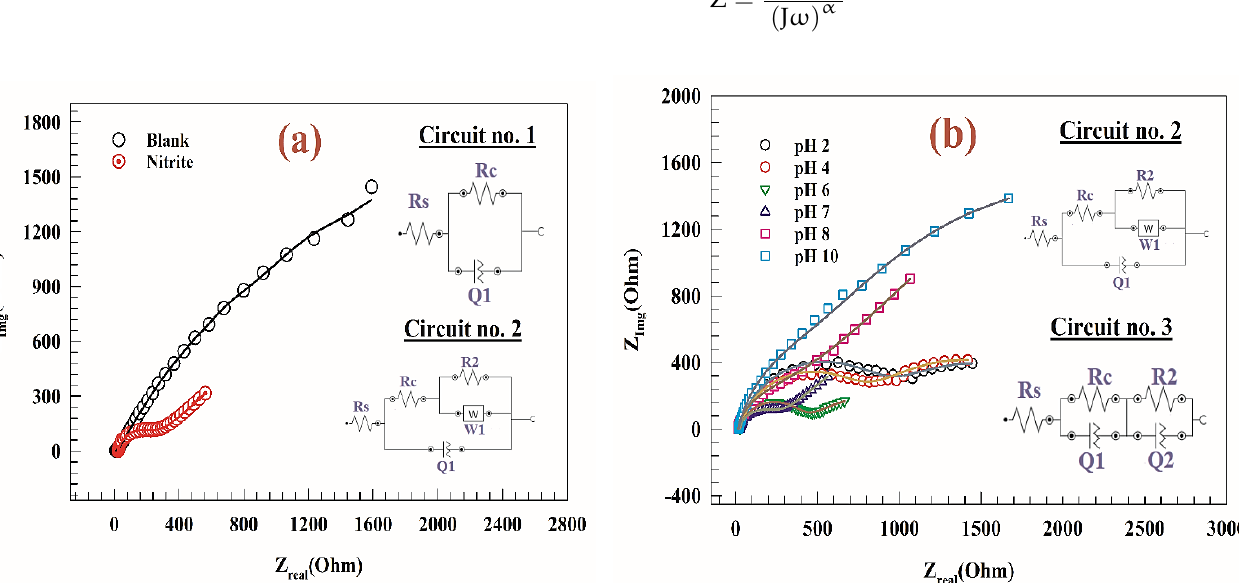
Figure 8. ( a ) Nyquist plots of modified electrode GC/PANI/NiOnF at constant AC potential of 1.0 V in the presence and absence of nitrite. ( b ) Nyquist plot of the modified GC/PANI/NiOnF at AC Potential of 1.0 V at different solution pH (2–10). Inset figures: the fitting circuits of the corresponding EIS result.